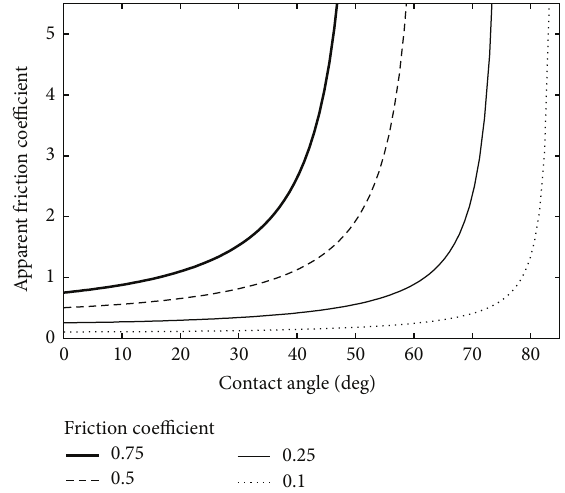
Figure 4: Relationship between the apparent friction coefficient and contact